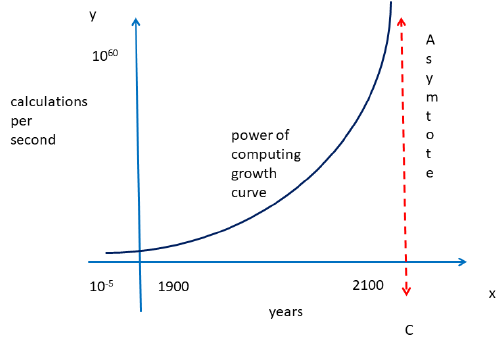
Figure 2. The exponential scale of technological growth (as in [19]).